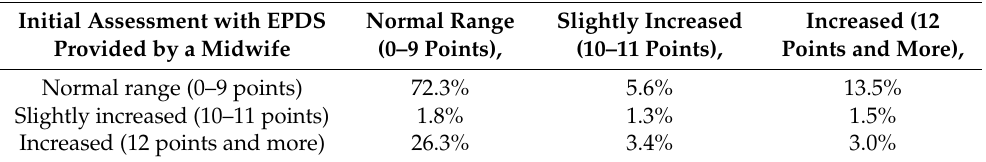
Table 4. Change in the EPDS category (extracted based on the cut-off points) among women who took part in the follow-up and in the initial assessment provided by the midwife had an EPDS total score falling within one of the three categories: standard range, slightly increased, or increased severity of PPD; n = 1227. Follow-Up Assessment with EPDS 1 Initial Assessment with EPDS Normal Range Slightly Increased Increased (12 Provided by a Midwife (0–9 Points), (10–11 Points), Points and More), Normal range (0–9 points) 72.3% 5.6% 13.5% Slightly increased (10–11 points) 1.8% 1.3% 1.5% Increased (12 points and more) 26.3% 3.4%